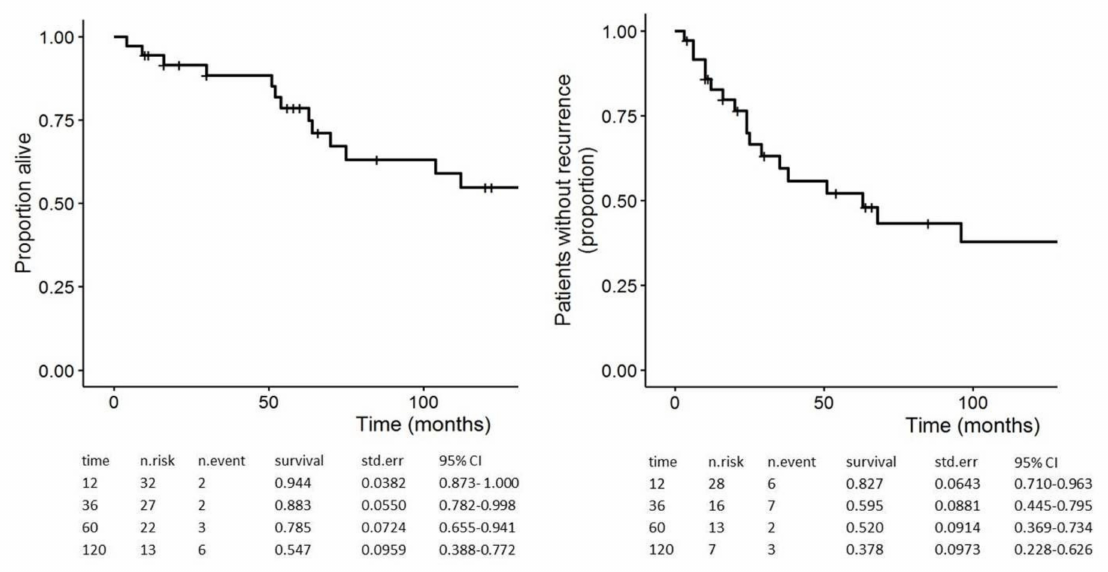
Figure 2. Kaplan-Meier estimates for overall survival (OS) (left) and disease-free survival (DFS) (right) of 36 patients after pancreatic surgery for